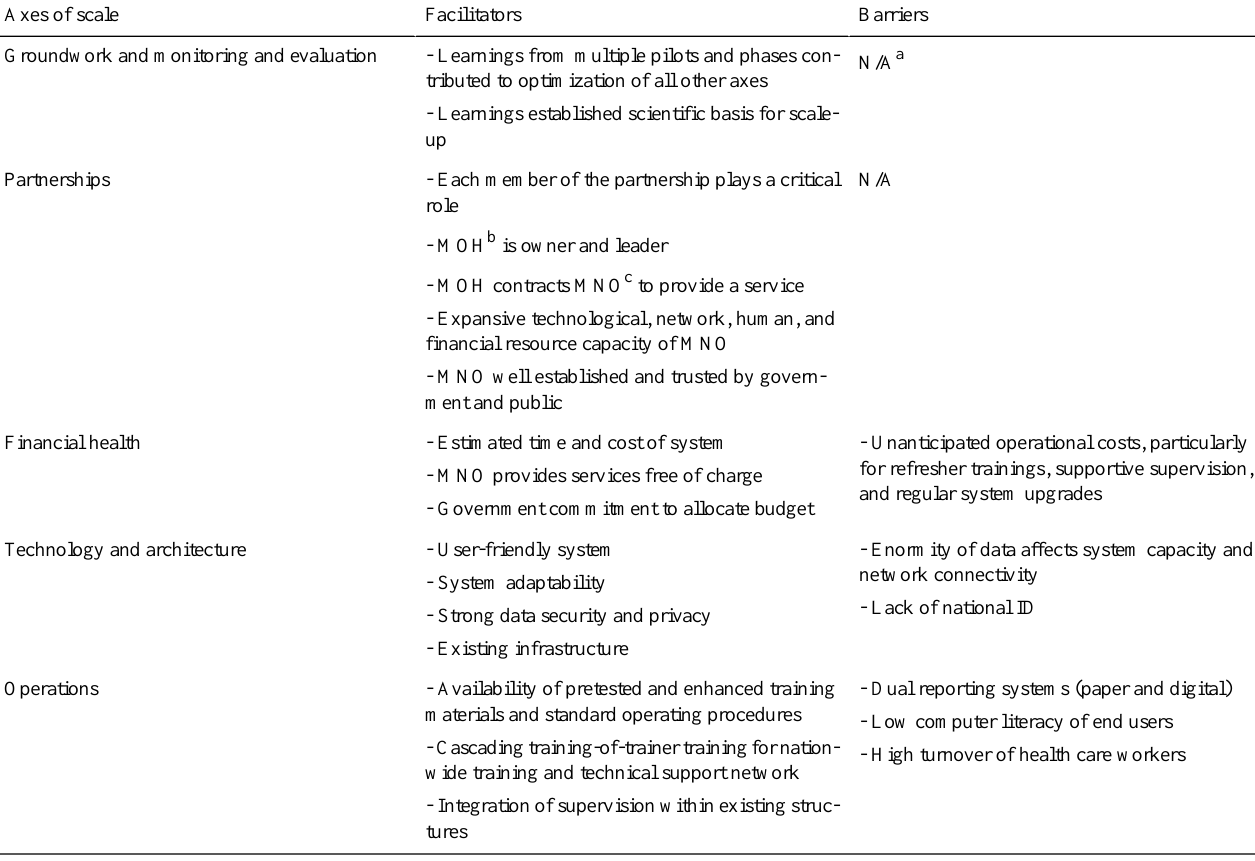
Table 1. Key facilitators and barriers to scale-up. BarriersFacilitatorsAxes of